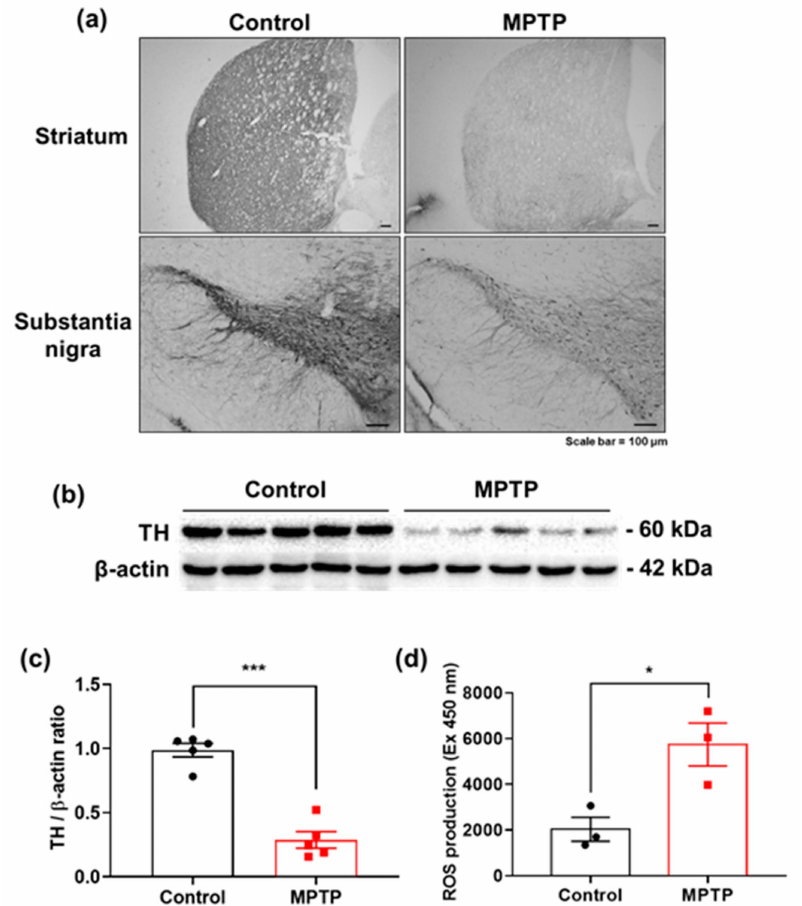
Figure 6. ( a ) Immunohistochemistry stained with TH antibody reveals that TH immunoreactivity clearly reduced by MPTP impaired the nigrostriatal pathway in both STR and SN. Scale bar = 100 µ m; ( b ) Western blot analysis showing that TH levels in the STR region are lower in the MPTP-treated group than in controls; ( c ) Densitometric analysis of TH levels in the STR (control in black and MPTP in red color); ( d ) Level of reactive oxygen species (ROS) measured using DCF-DA, showing significantly elevated ROS production and increased oxidative stress in MPTP-treated STR. The results are presented as mean ± SE ( n = 3–5 mice/group). * p < 0.05, *** p < 0.001 vs. naïve controls. The analysis was conducted by unpaired t -test with Fisher’s PLSD procedure (control in black and MPTP in red